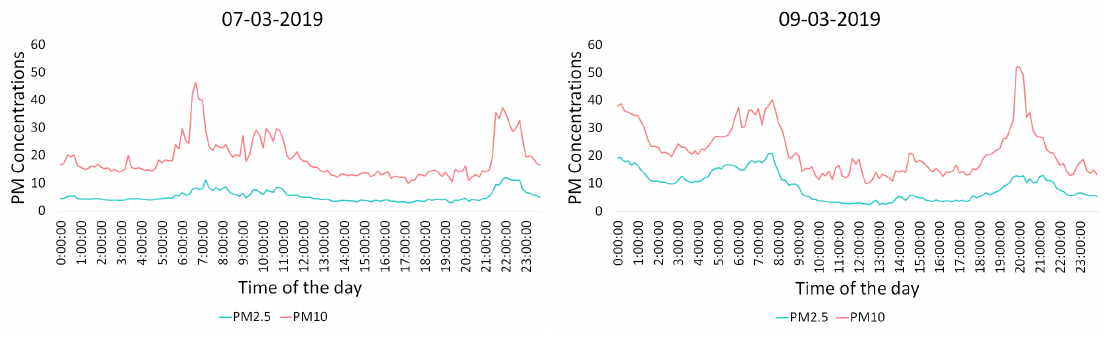
( a ) PM concentrations in µ g/m 3 for 7 March.